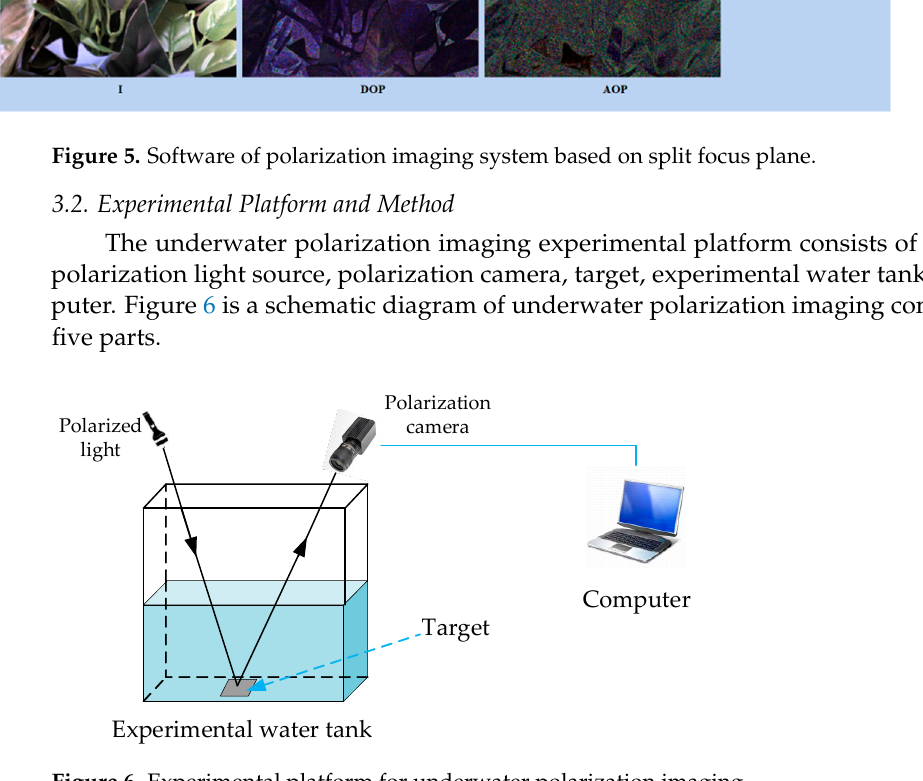
Figure 5. Software of polarization imaging system based on split focus plane.